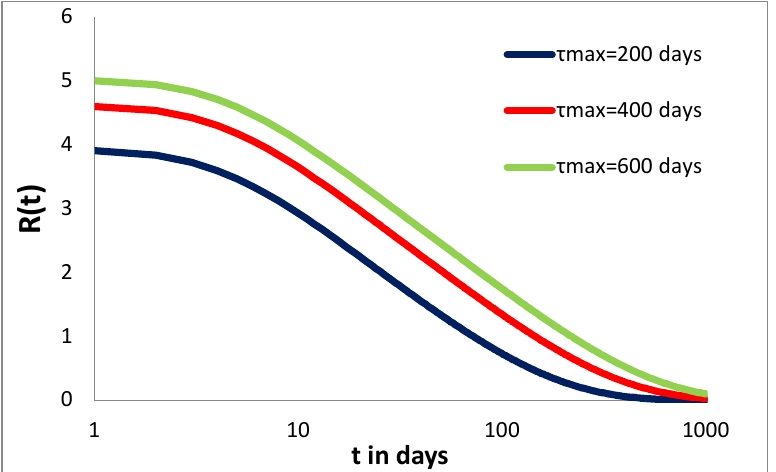
Figure 2. The relaxation function R(t) (see Equation (6) in the text) for τ min = 5 days and τ max = 200, 400, 600 days.